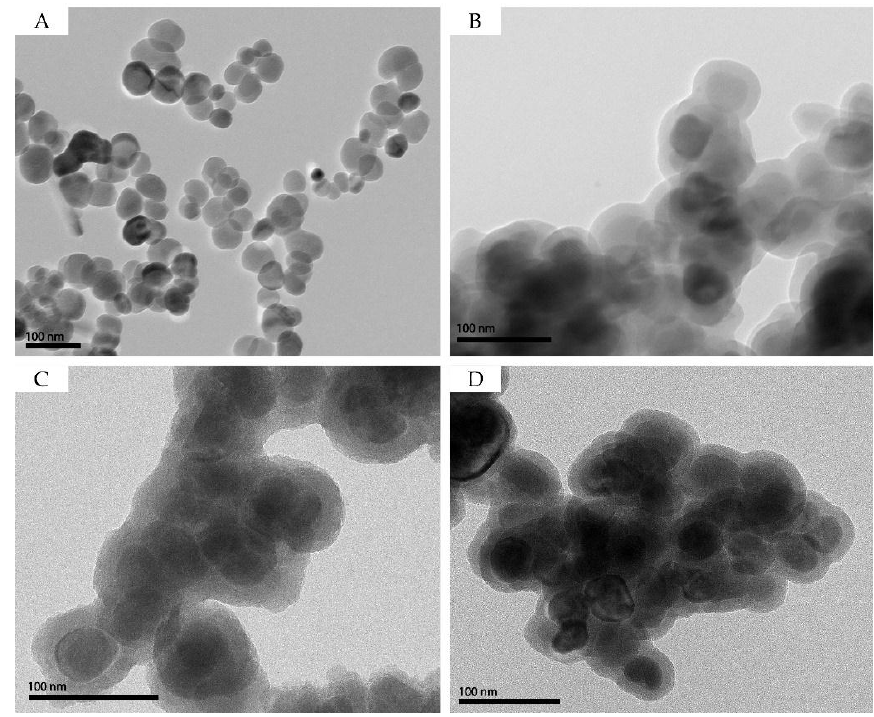
Figure 2. Transmission electron microscopy (TEM) images of ( A ) Fe 3 O 4 ; ( B ) Fe 3 O 4 @SiO 2 ; ( C ) Fe 3 O 4 @SiO 2 /SiStarch and ( D ) Fe 3 O 4 @SiO 2 /SiCRG.